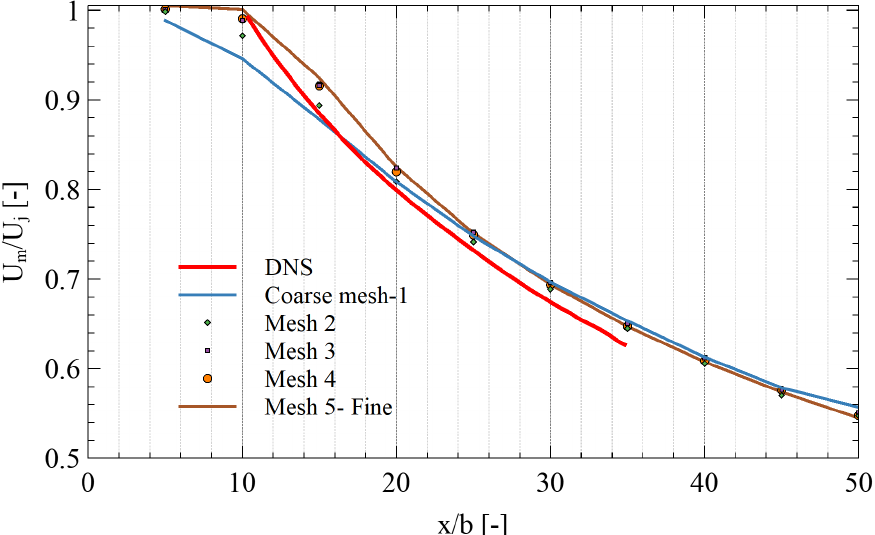
Figure 6. Grid convergence study of κ − ω